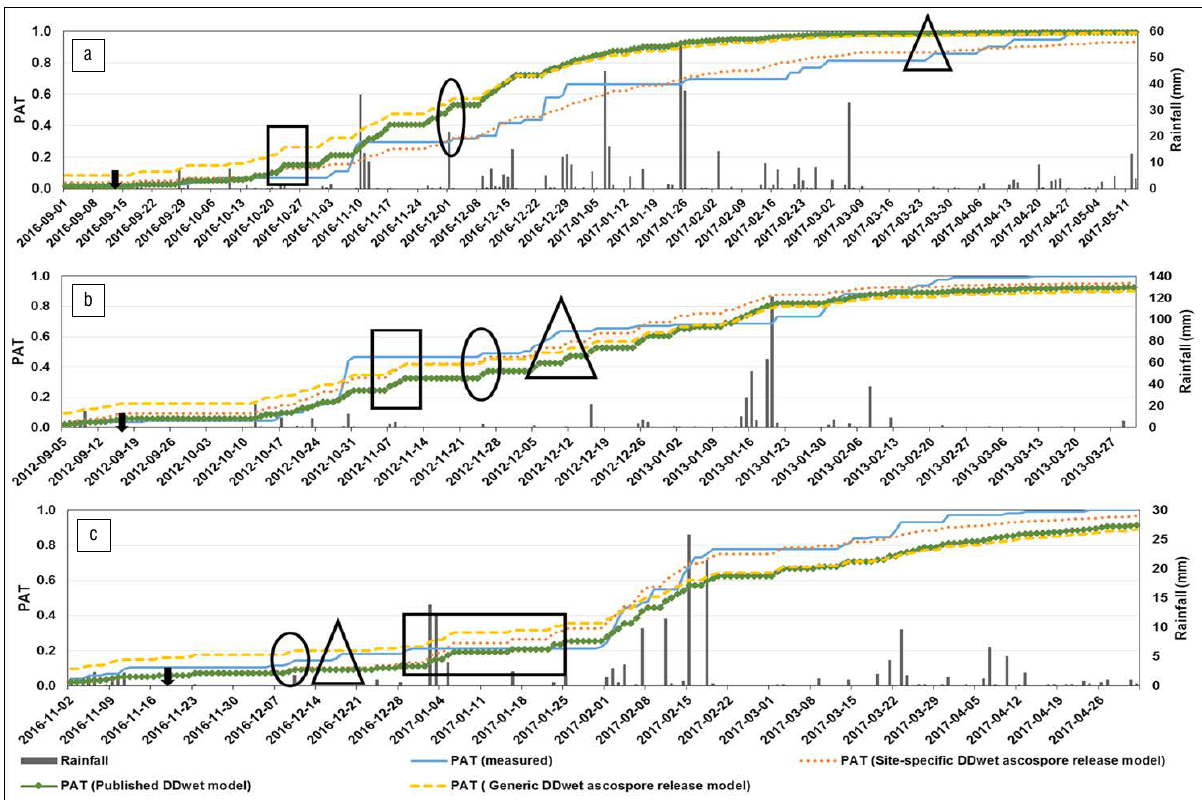
Figure 1: Observed cumulative proportion of airborne Phyllosticta ascospores trapped (measured PAT), the onset of ascospore release as predicted by the DDwet pseudothecium maturation model (black arrow) [P = exp(-exp(-(-3.131 + 0.007 × DDtemp - 0.007 × DDwet))), at p = 0.5], PAT predicted using the generic DDwet ascospore release model [PAT (generic DDwet model) = exp(-2.452 × exp(-0.004 × DDwet2))], a published model [PAT (published model) = exp(-4.096 × exp(-0.005 × DDwet2))] 25 , as well as the DDwet ascospore release model specific to: (a) Letsitele B during 2016/2017 [PAT (site-specific DDwet model) = exp(-3.186 × exp(-0.003 × DDwet2))]; (b) Letsitele A during 2012/2013 [PAT = exp(-3.568 × exp(-0.005 × DDwet2))] and (c) Kirkwood B during 2016/2017 seasons [PAT = exp(-4.458 × exp(-0.006 × DDwet2))]. DDtemp = accumulated degree-days (°C) using 1 July as biofix and 10 °C as base temperature, and DDwet = DDtemp accumulation only on days with measurable rainfall (>0.1 mm) or vapour pressure deficit (VPD) <5 hPa, and DDwet2 calculated from the first seasonal ascospore release date as biofix. Cases in which models missed measured ascospore peaks (triangle), predicted false peaks (rectangle) or accurately predicted ascospore peaks (circle) are